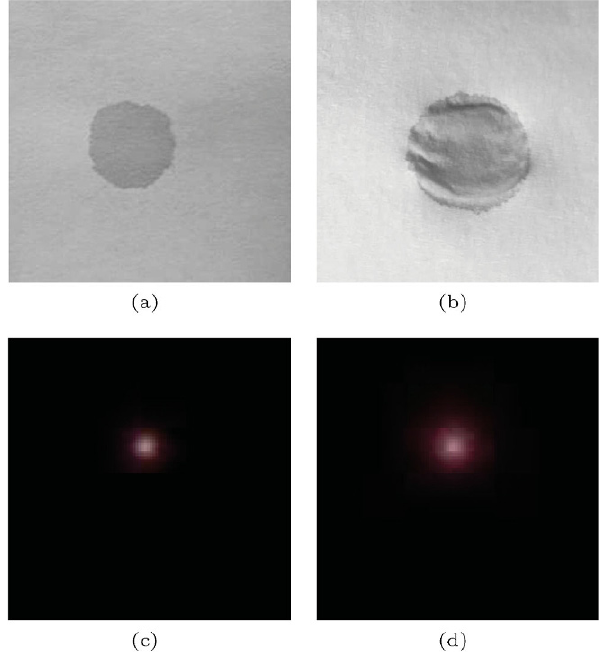
Fig. 12 Calculating strength coefficients in the DCC model by solving an inverse problem. (a, b) Results of dripping a drop of water onto two different papers with different diffusion coefficients. (c, d) Simulated diffusion results using the diffusion coefficients calculated from (a) and (b),